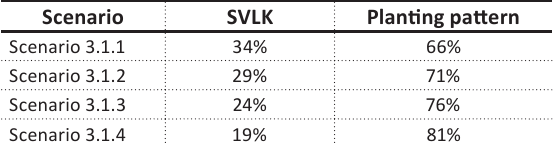
Table 5. Combination scenario 3.1 of sub-budget